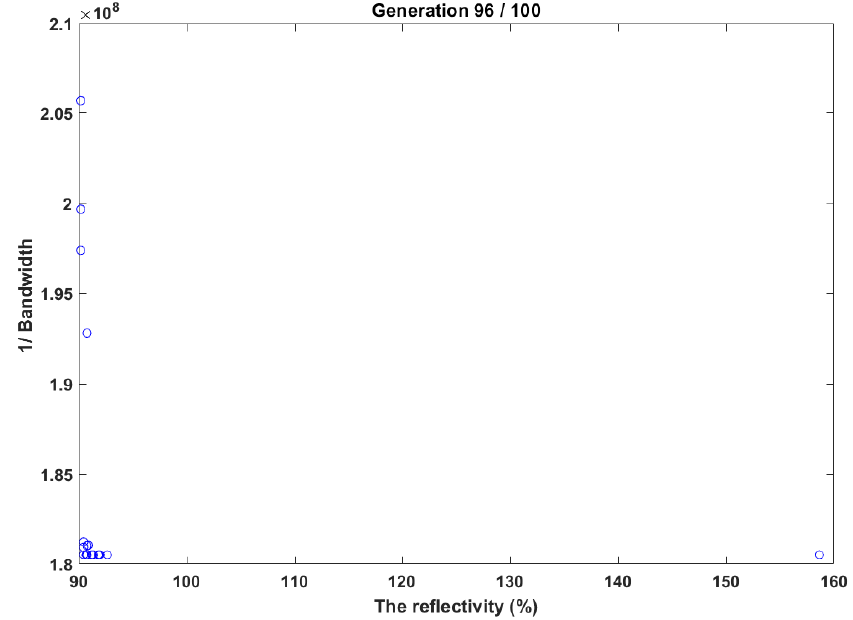
Figure 6. The testing of RNSGA-II for increasing the reflectivity and decreasing the bandwidth.